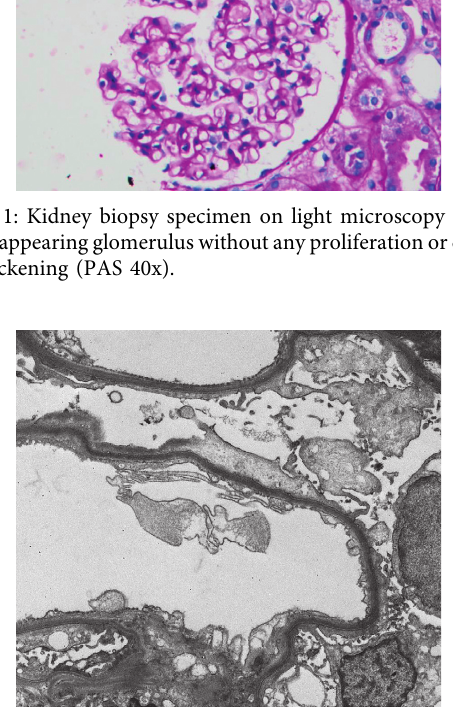
Figure 2: Kidney biopsy specimen with electron microscopy showing diffuse effacement of visceral epithelial cell foot processes (TEM